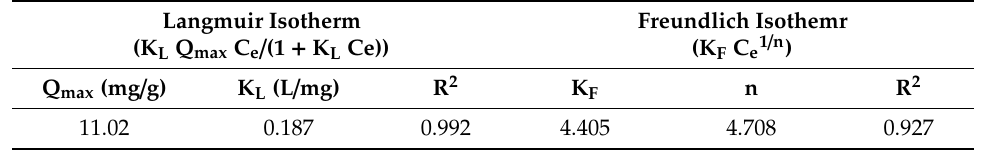
Table 3. The isotherm constants for removal of antimony by BP.